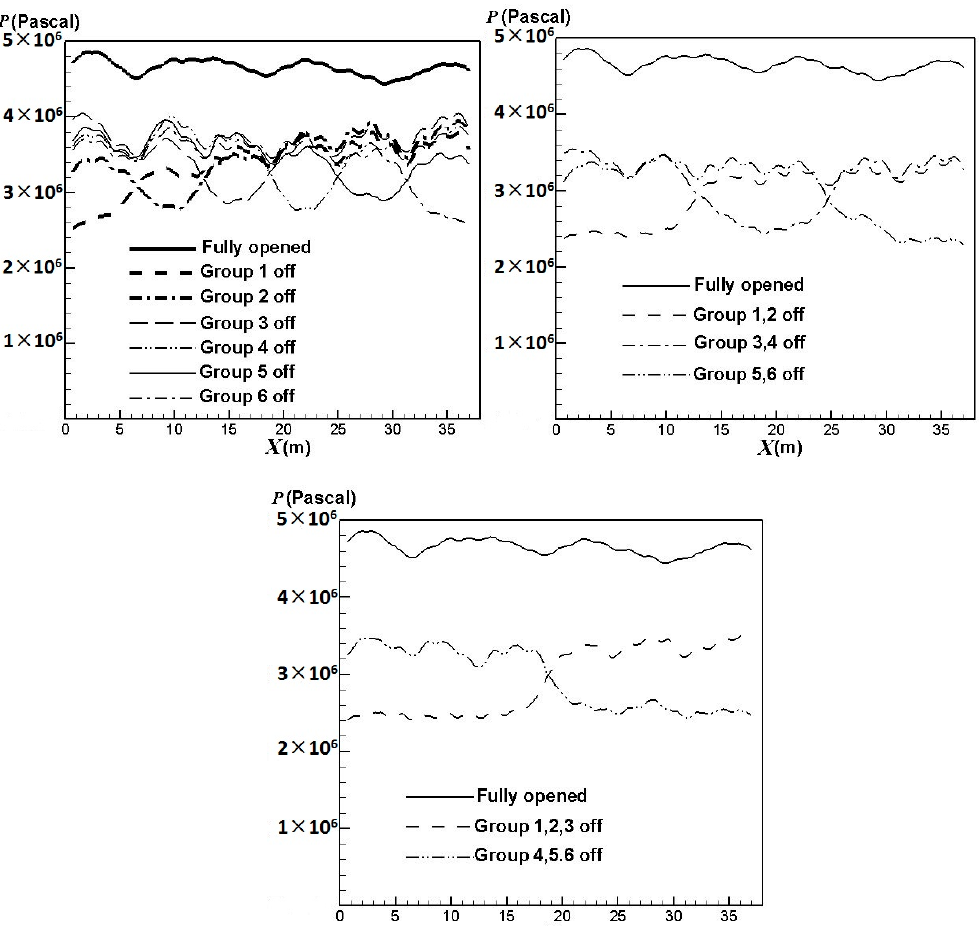
Figure 9. Average inner surface pressures of the catalyst tubes using different burners on/off combinations. The lifetimes for the catalyst tubes of different burners on/off combinations can be estimated from the calculated maximum outer surface temperatures and maximum inner surface pressures of the catalyst tubes. The result is shown in Figure 10. It can be ob- served that turning off some burners is beneficial to the catalyst tube lifetime, especially for the catalyst tubes in the corresponding areas of burners turned off. The catalyst tube lifetime will be longer when more burners are turned off. Turning off the upstream burners is more efficient to the catalyst tube lifetime while turning off the central burners is less efficient. Comparing Figure 6 and Figures 8–10, it can be observed that turning off some burners can reduce the catalyst tube temperatures and pressures, and increase the catalyst tube lifetimes. The main drawback is the reduction in hydrogen yields.